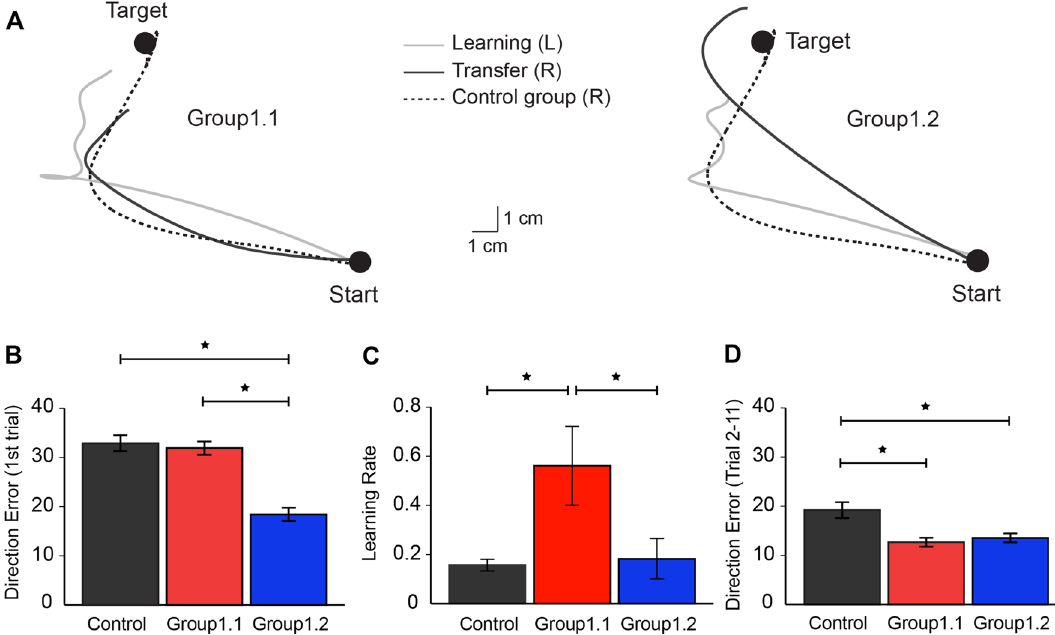
was plotted in dashed line. ( B ) Mean errors of the first trial in the transfer session for Group1.1 (red), Group1.2 (blue), and control (black) (mean ± standard error). ( C ) Comparison of learning rates in the transfer session